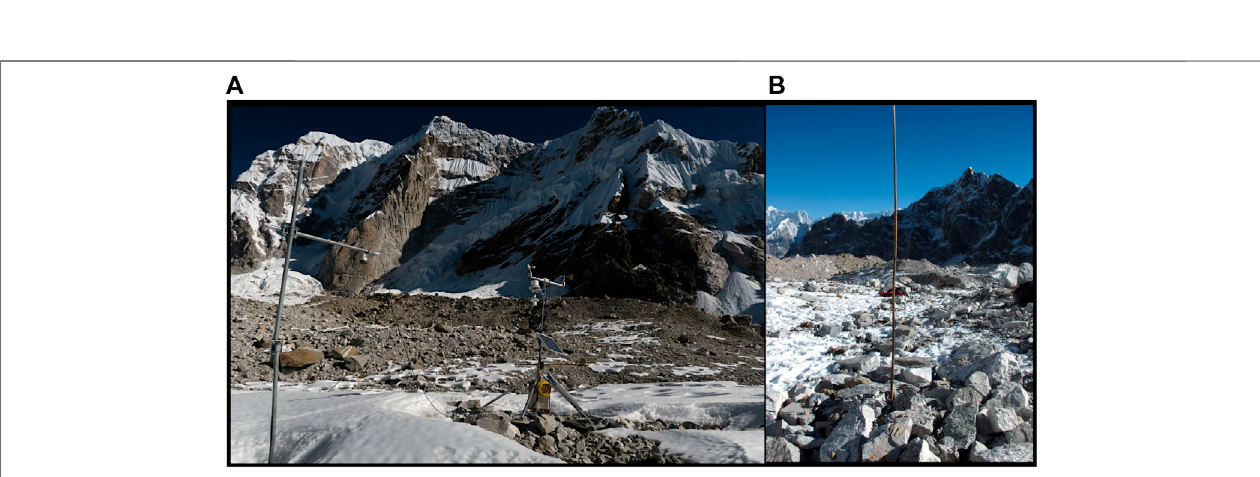
FIGURE 3 | (A) NCN-AWS. The photograph shows the relative positions of the sonic ranger and other meteorological instruments, the tilt in the tripod supporting the sonic ranger, and patchy snow cover. (B) One ablation stake in the “ stake farm ” , showing the natural debris surface. Note the elevated patch of debris around the stake, and patchy snow cover. The photographs were taken on 10 November